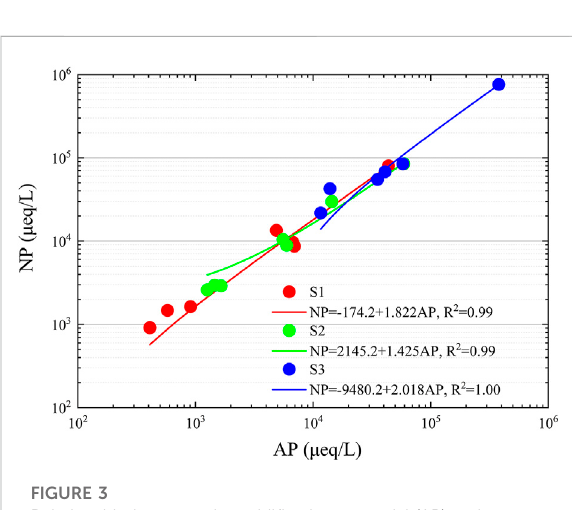
FIGURE 3 Relationship between the acidi fi cation potential (AP) and neutralization potential (NP) of three-stage fog water in Donghai site. The S1, S2, and S3 represent the sample for the large droplets of diameter larger than 22 μ m, medium droplets of diameter within 16 – 22 μ m, and small droplets of diameter within 4 – 16 μ m,